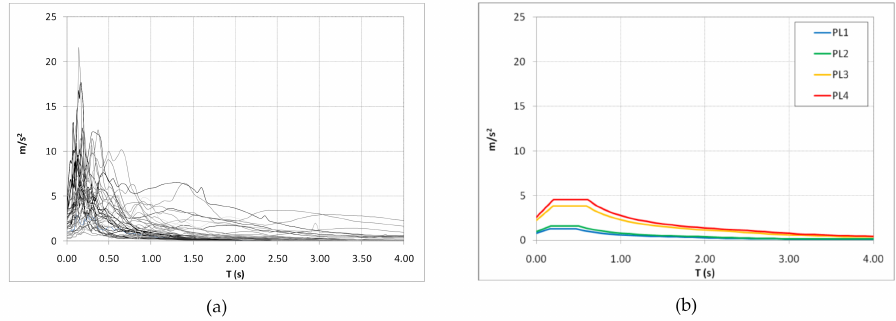
Figure 7. Elastic spectra of the considered records ( a ) and PL spectra code ( b ). Here, the elastic spectra derived from the code for the building under study are reported.